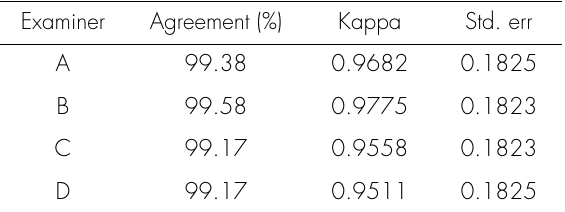
Table X. Intra-examiner agreement and Kappa of the IOTN-DHC for the photographs of study models and actual study models. Examiner